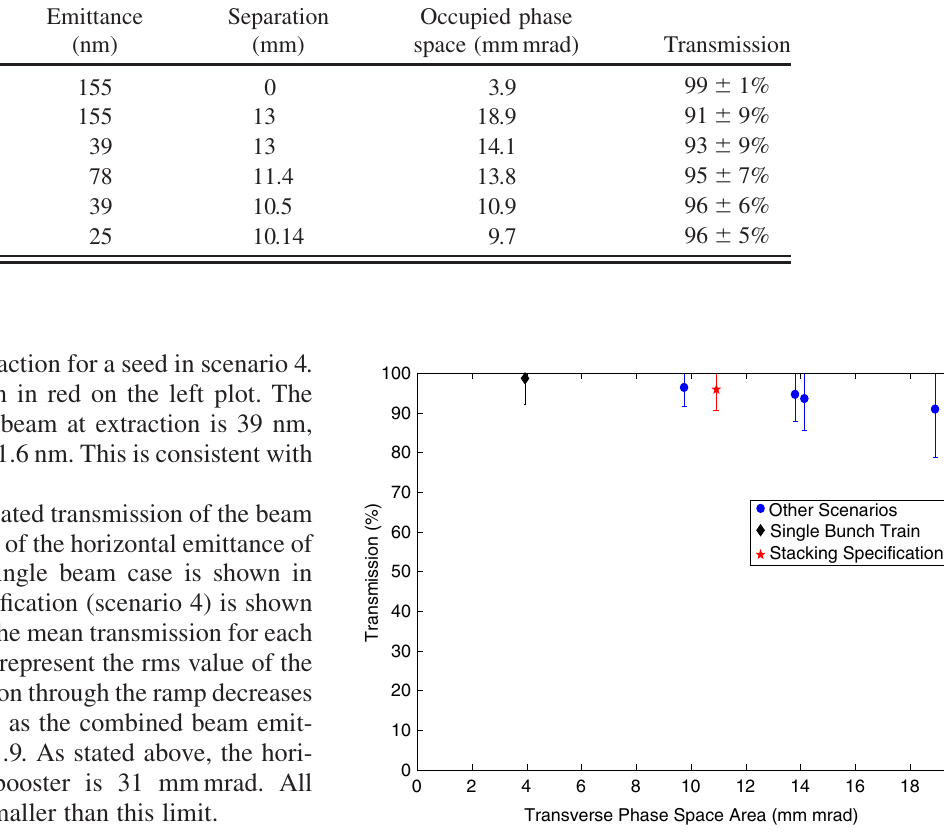
TABLE III. Various injected bunch parameters using in stacking simulations. Scenario